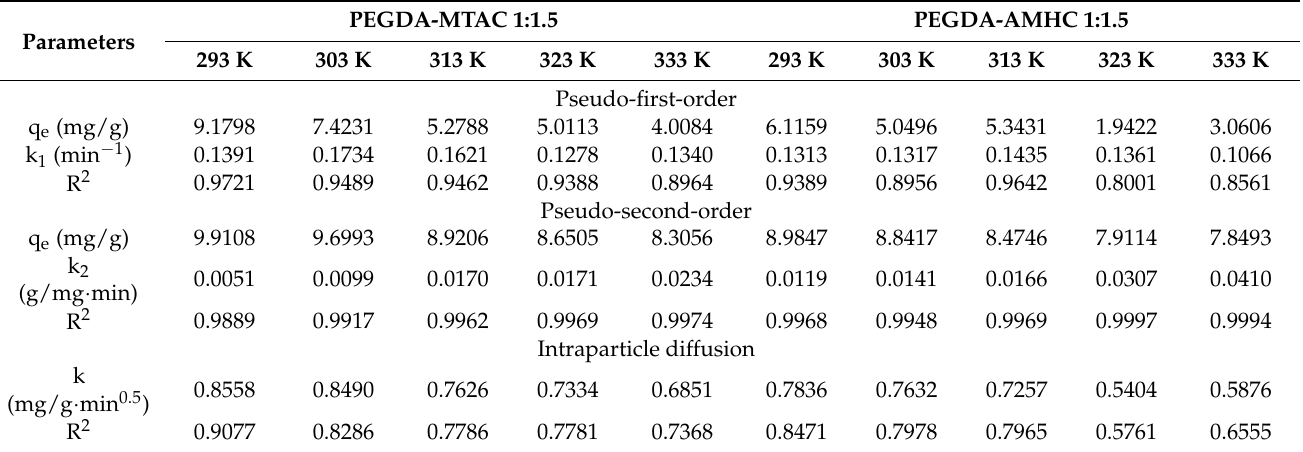
Table 2. Adsorption kinetic parameters of the adsorption of nitrate onto M 1.5 and N 1.5 in aque- ous solution.